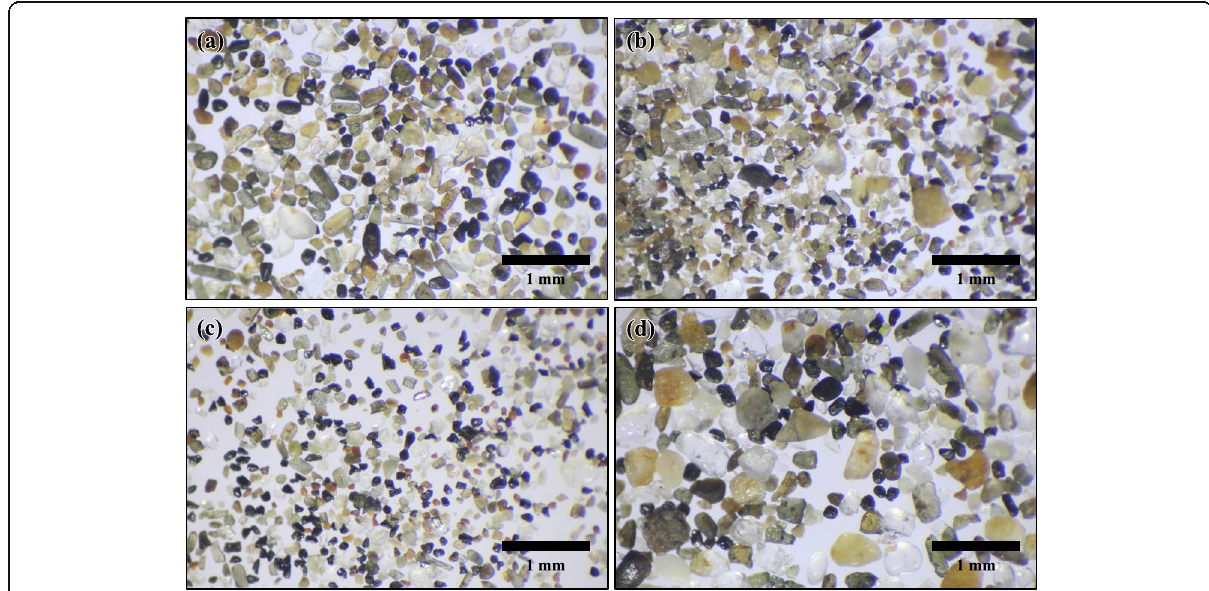
Fig. 3 Microscopic photo of sands contained in the a upper sandy layer (event 1), b above mud – peat boundary (event 2), c lower sandy layer (event 3), and d the Kimiga-hama